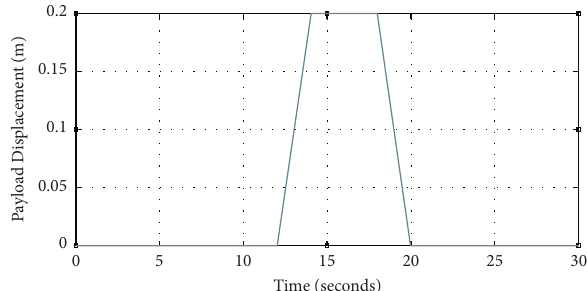
Figure 4: Te frst input signal applied on the payload.